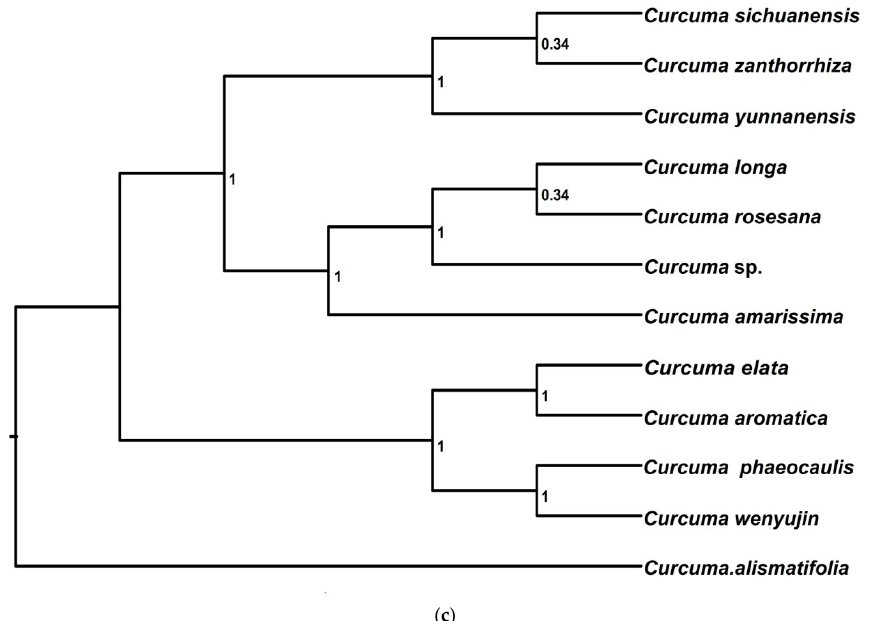
Figure 4. Phylogeny from multi-locus tree inference method: MCC tree in BEAST recovered with ( a ) 902 loci for pyRAD, ( b ) 8574 loci for STACKS, and ( c ) coding gene for chloroplast genome, the posterior probabilities for each clade. The posterior probabilities were on the species clade. In Figure 4b, Group I consisted of C. xanthorrhiza , C. elata , C. phaeocaulis , C. wenyujin , and C. amarissima , and Group II consisted of C. longa , C. sichuanensis , C. rosesana , C. sp . , C. yunnanensis , and C. aromatica .